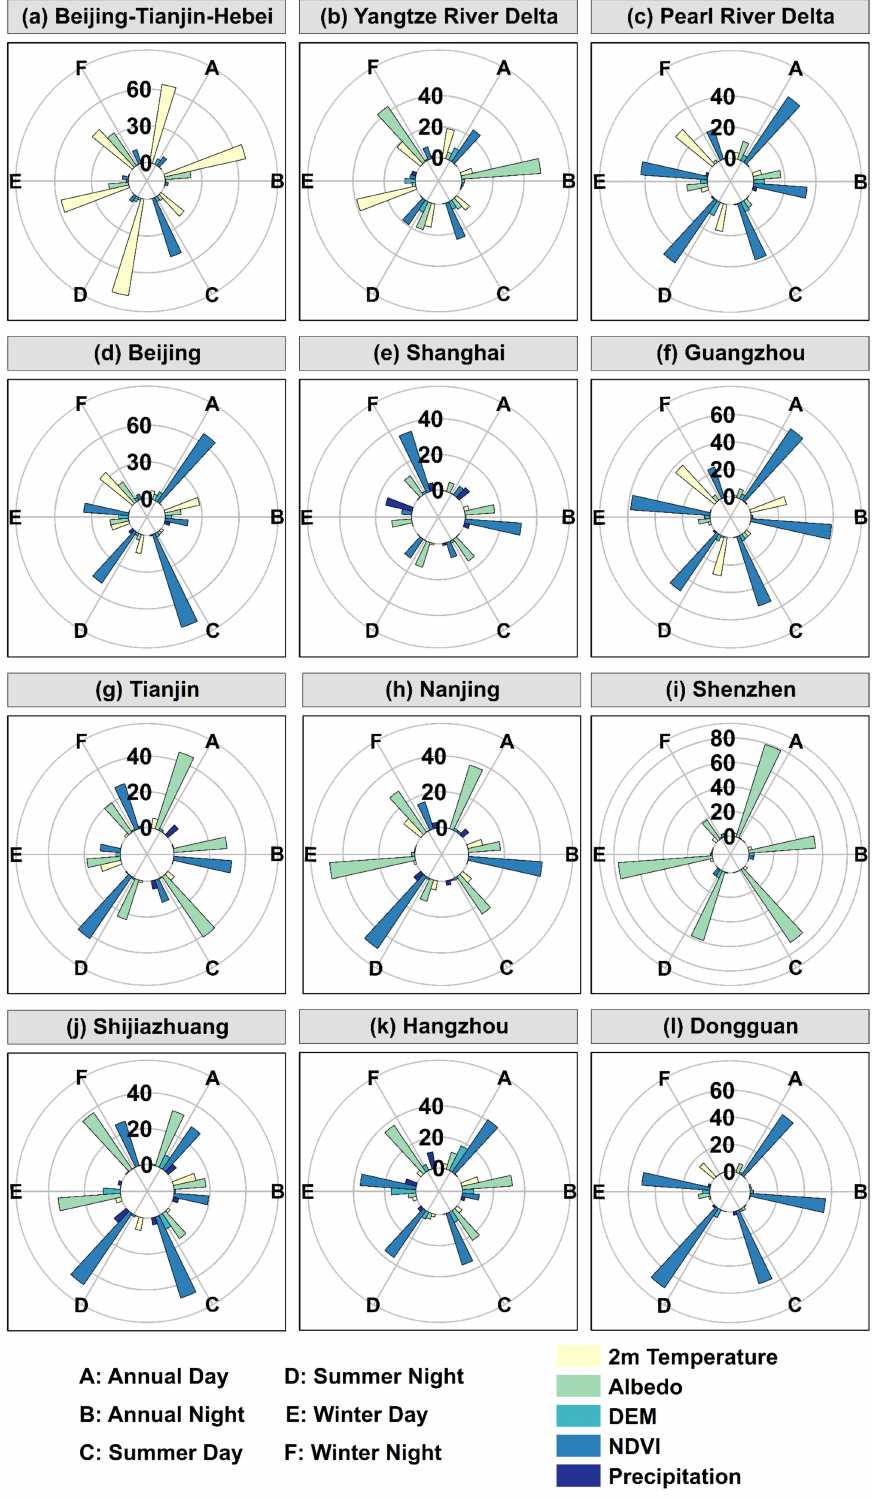
Figure 11. Fractional contributions of vegetation coverage, albedo, air temperature, precipitation and altitude to LST variability during daytime and nighttime of annual, summer and winter seasons across di ff erent cities and urban